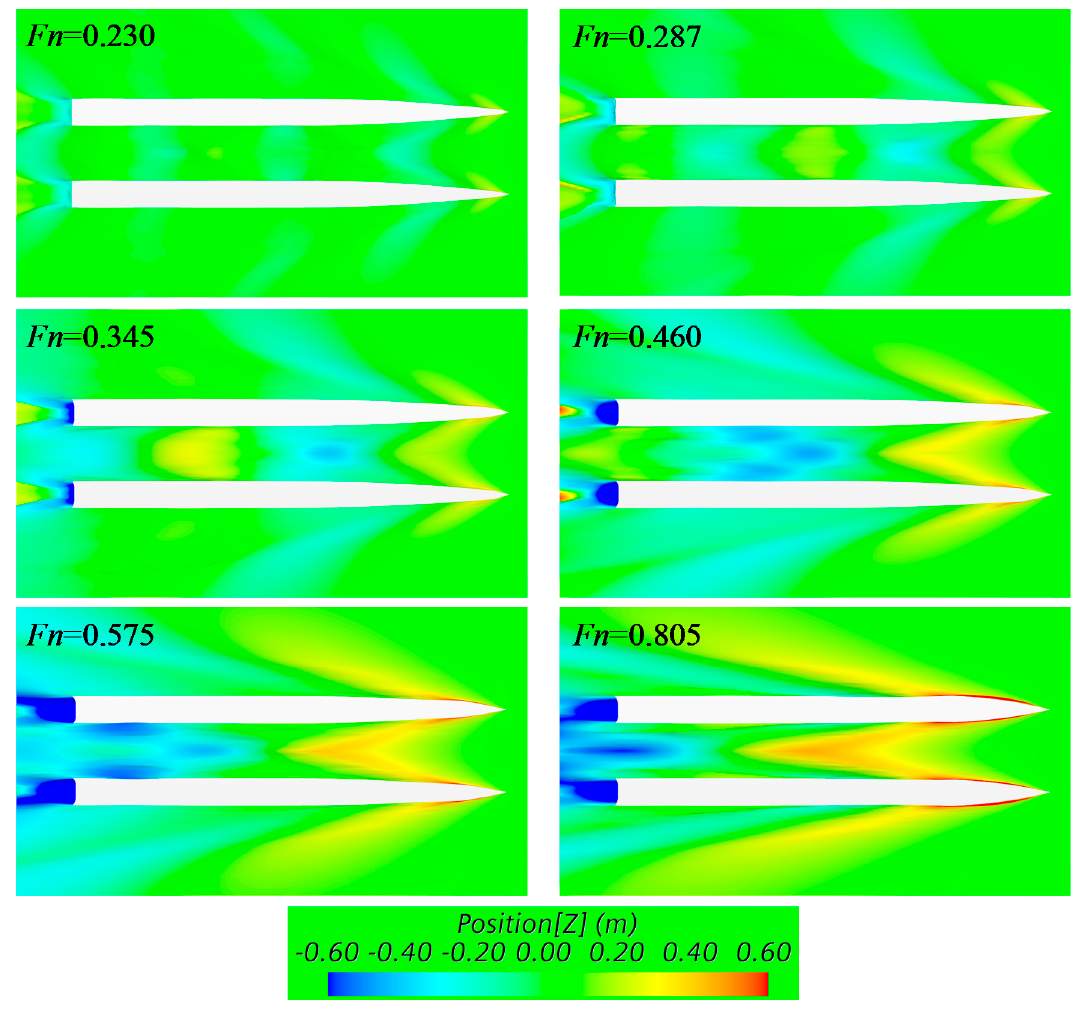
Figure 14. The wave interaction between demihulls in deep water.